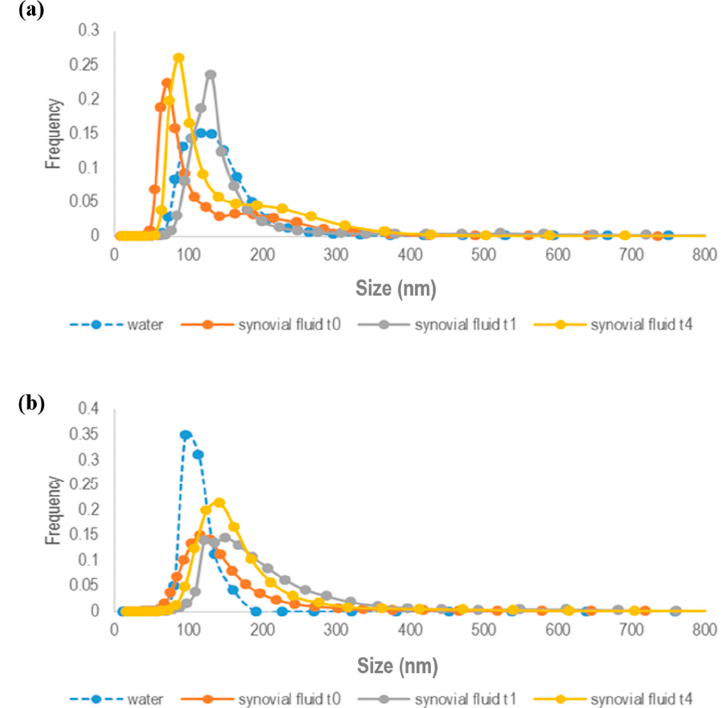
Figure 2. Size distribution of: ( a ) GE11-PLGA/PEG-PLGA-RhB NPs; and ( b ) PLGA/PEG-PLGA-RhB NPs in synovial fluid. Measurements have been carried out by fSPT technique at time zero ( t 0 ), after 1 h ( t 1 ) and 4 h ( t 4 ) of incubation in synovial fluid. The stripped blue line corresponds to NPs size distribution in water and it was used as control.